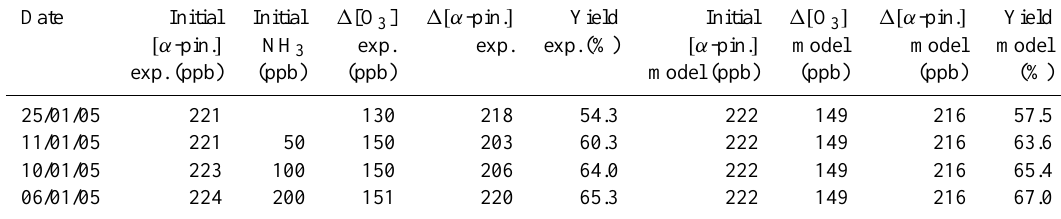
Table 4. Initial conditions and results from the α -pinene–O 3 –NH 3 –CO experiments (Na et al., 2007) and base case model simulations.